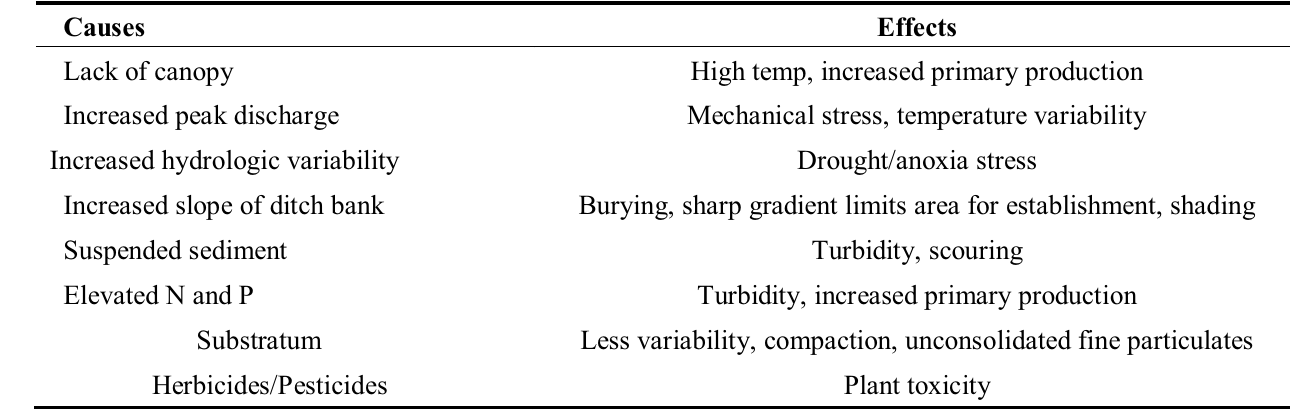
Table 3. Localized habitat parameters affecting macrophytes in wetlands and streams in the agricultural landscape. Note that these factors also indirectly affect macrophytes via changes in community structure of consumers and